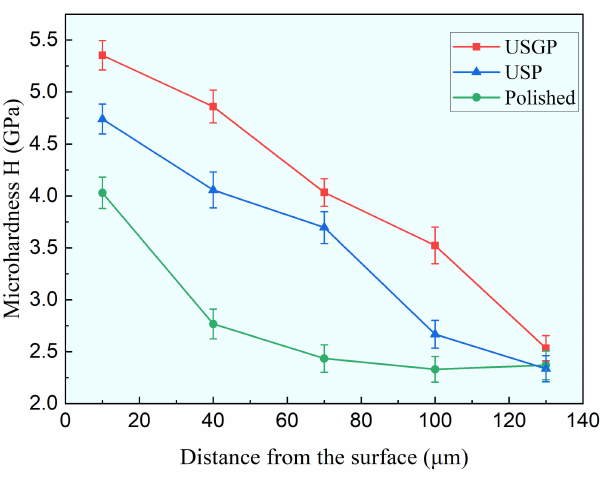
Figure 9. The microhardness H variation from sub-surface to substrate of USGP, USP, and pol- ished